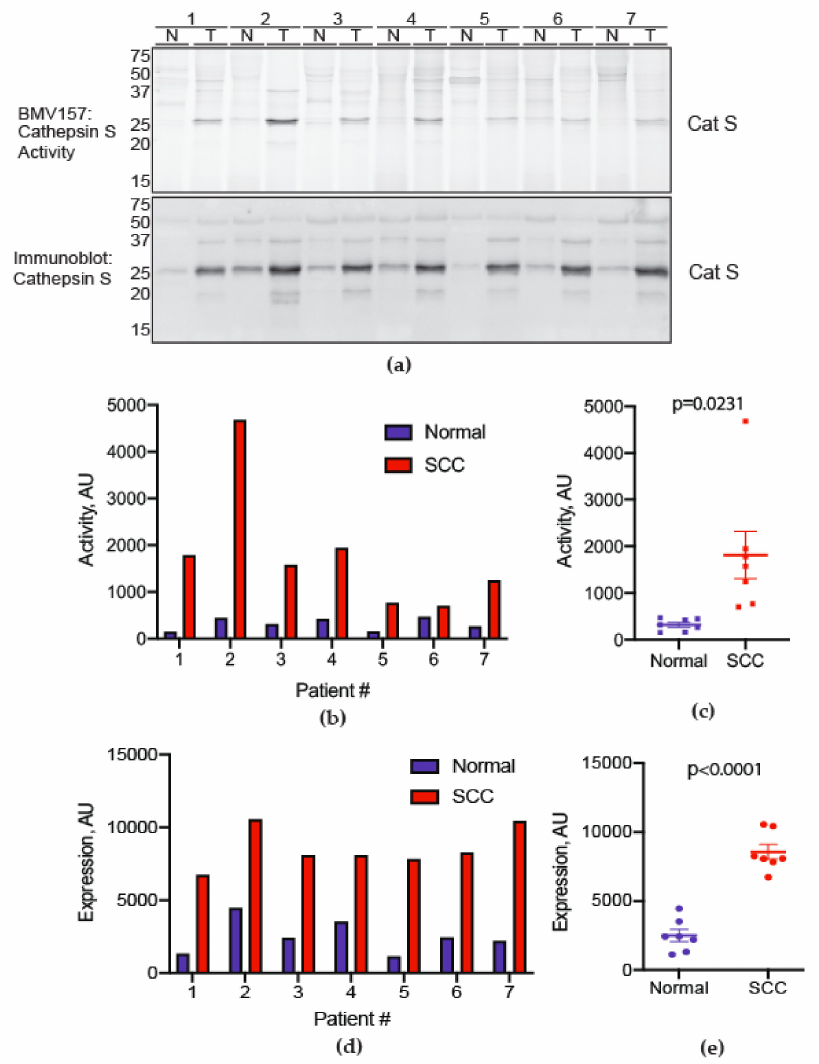
Figure 1. Cathepsin S activity is increased in human oral cancer compared to match normal tissue. ( a ) Active cathepsin S labeled by BMV157 (upper panel) as shown by in-gel fluorescence and total cathepsin S immunoreactivity (lower panel) in oral SCC biopsies (T) and patient-matched normal oral mucosa (N). The gel (upper panel) was transferred to nitrocellulose and immunoblotted for total cathepsin S levels (lower panel). The uncropped western blot figure is presented in Figure S1. ( b ) Densitometry of the 25 kDa species labeled by BMV157, displayed as individual values for all normal and oral SCC samples. ( c ) Average cathepsin S activity was higher in oral SCC samples (independent samples Student’s t -test). ( d ) Densitometry of the 25 kDa species labeled by BMV157, displayed as individual values for all normal and oral SCC samples. ( e ) Average total cathepsin S levels were higher in oral SCC samples (independent samples Student’s t